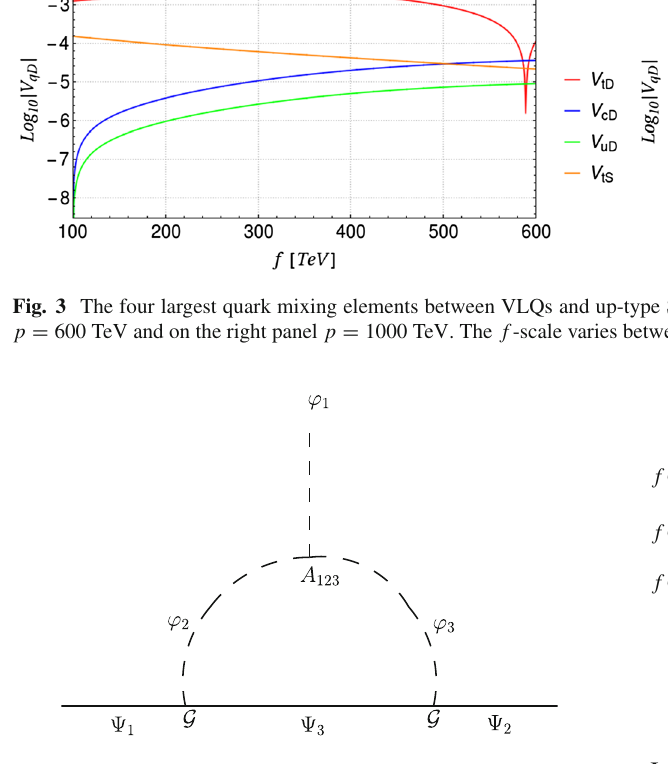
Fig. 4 One-loop topology contributing to the radiatively generated Yukawa interactions. G denotes a Yukawa coupling with D-term ori-